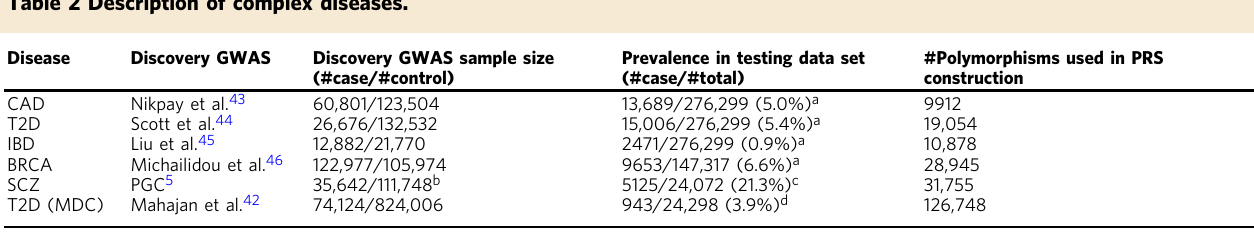
Table 2 Description of complex